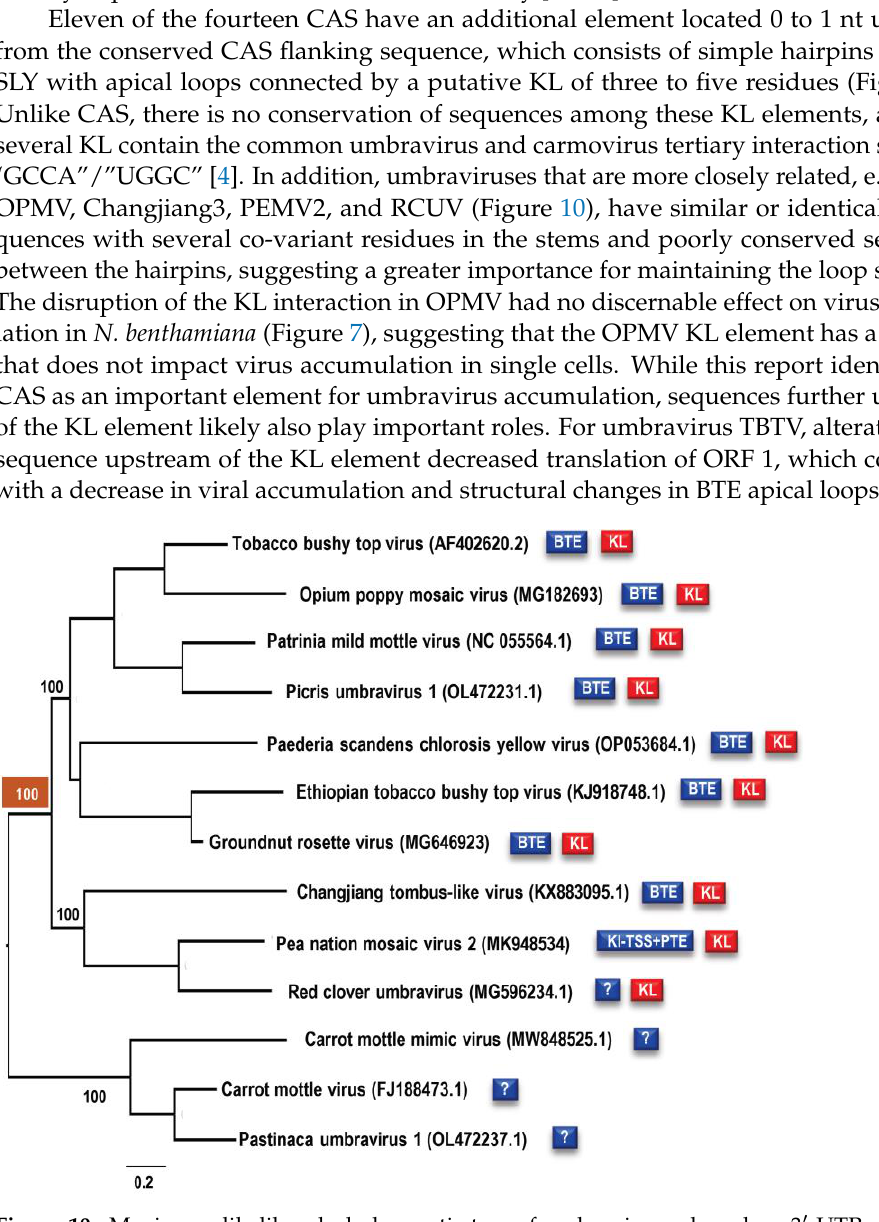
Figure 10. Maximum likelihood phylogenetic tree of umbraviruses based on 3ʹ UTR nucleotide sequences. Values above each branch indicate bootstrap support in the percentage out of 1000 bootstraps. The bottom scale bar indicates nucleotide substitutions per site. The blue and red boxes next to virus names indicate the type of CITE (if known) and the presence of the KL element. The bootstrap support for the branch containing closely related umbraviruses possessing the conserved KL element is highlighted in brown.